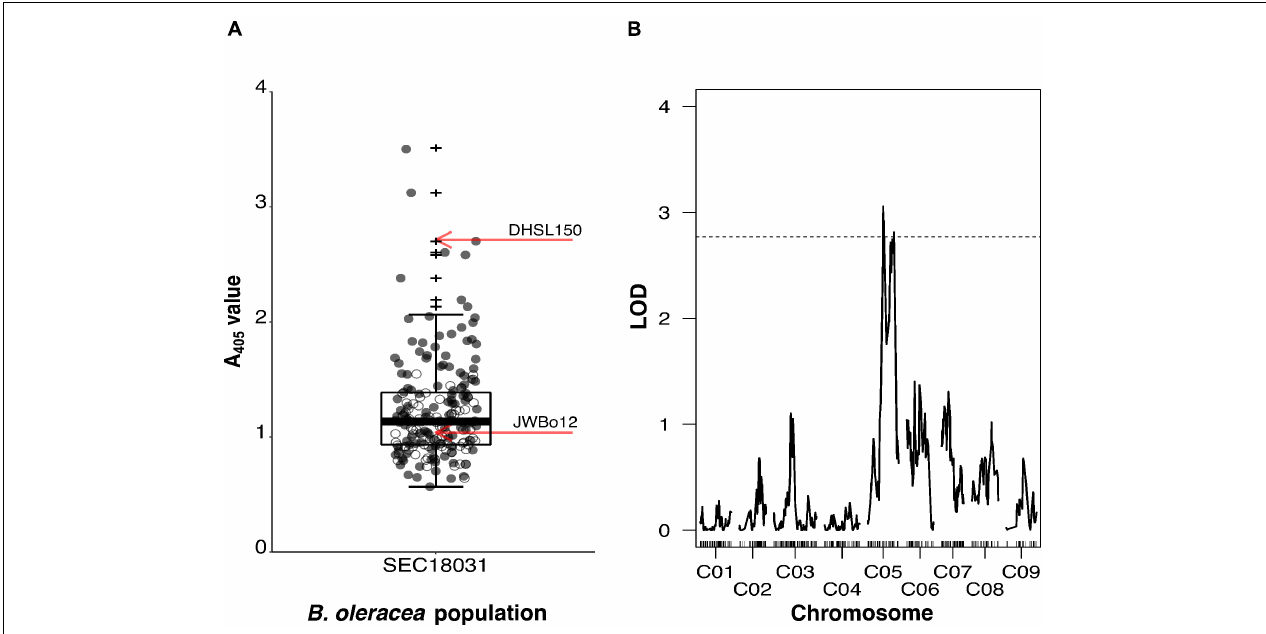
FIGURE 2 | Mapping of TuYV resistance from Brassica oleracea line JWBo12 using the segregating BC 1 population SEC18031. SEC18031 was produced from the cross DHSL150 × F 1 , where the F 1 plant was resistant to TuYV. (A) Enzyme-Linked Immunosorbent Assay A 405 values for BC 1 population SEC18031 ( n = 200) and mean values for S 1 populations of the TuYV-resistant parental line JWBo12 ( n = 7) and TuYV-susceptible parental line DHSL150 ( n = 18) indicated by red arrows. Individuals subsequently genotyped for quantitative trait locus (QTL) analysis are indicated as grey points. (B) The LOD plot of QTL analysis of BC 1 population SEC18031, using normalised log 10 (A 405 ) values and Haley–Knott one-dimensional mapping. Genome-wide significance LOD threshold ( α ≤ 0.05) of 1,000 permutations is indicated by a dashed horizontal line. Outliers are indicated by